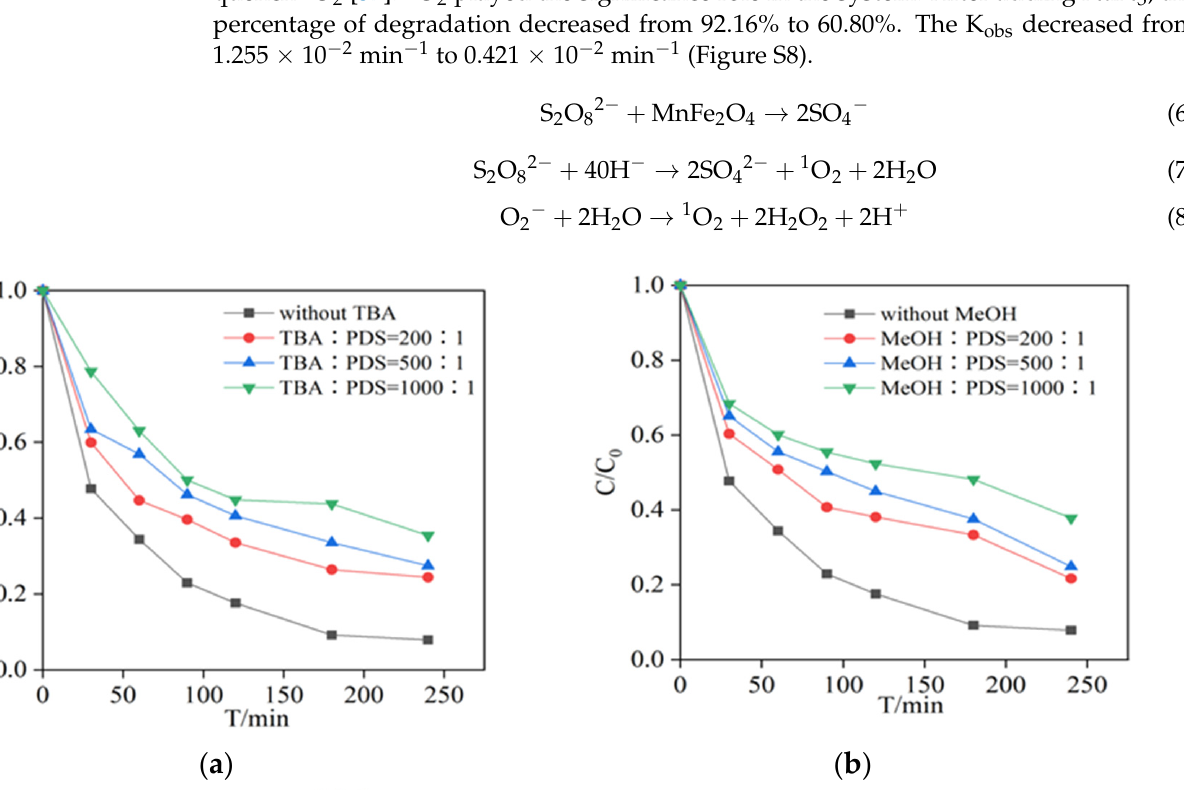
( c ) Figure 5. Effect of different ( a ) TBA, ( b ) MeOH and ( c ) NaN 3 concentration on degradation of PCA by PDS catalyzed with MnFe 2 O 4 .Experimental conditions: [PCA] = 20 mg/L, [PDS] = 2.4 mM, [MnFe 2 O 4 ] = 1.3 g/L and T = 25 °C. 3.5. Total Organic Carbon (TOC) Removal Efficiencies in MnFe 2 O 4 /PDS System A number of studies have shown that it is extremely difficult to obtain the full min- eralization of PCA by chemical treatment methods [38]. A high removal rate of organic matter does not mean that the organic matter is broken down into CO 2 and H 2 O, which may also be present as other small molecules [39]. The TOC was measured under dif- ferent PDS dosages. As displayed in Figure 6, when 0.4 mM of PDS was added into PCA solution, the removal rate of TOC was 23.50% in 240 min. However, the TOC removal rate was 35.07%, when 2.4 mM of PDS was added into PCA solution. The removal and mineralization rates of PCA were significantly increased. The results indicated that PCA could be effectively mineralized in the MnFe 2 O 4 /PDS system. The PCA was not com- pletely mineralized to H 2 O and CO 2 [40]. It is possible that inorganic or organic small molecule products of oxidation were developed in solution.